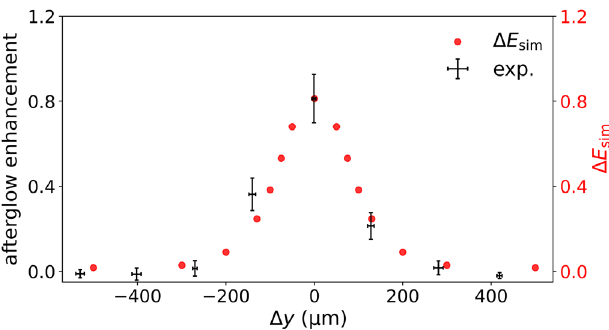
FIG. 4. Spatial alignment scan with 8 – 10 shots per setting with experimentally observed plasma afterglow enhancement (black) and normalized energy transfer obtained from simulation (red).